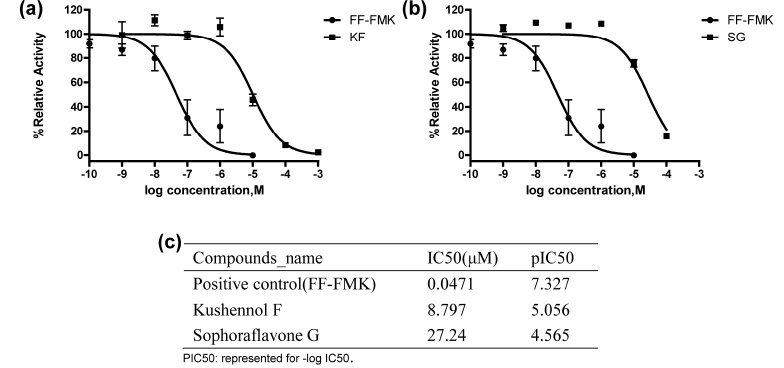
Figure 2. ( a – c ) Inhibitory effects of FF-FMK (Phe-Phe-Fluoromethylketone), Kushennol F (KF), and Sophoraflavone G (SG) on Cathepsin K activities.